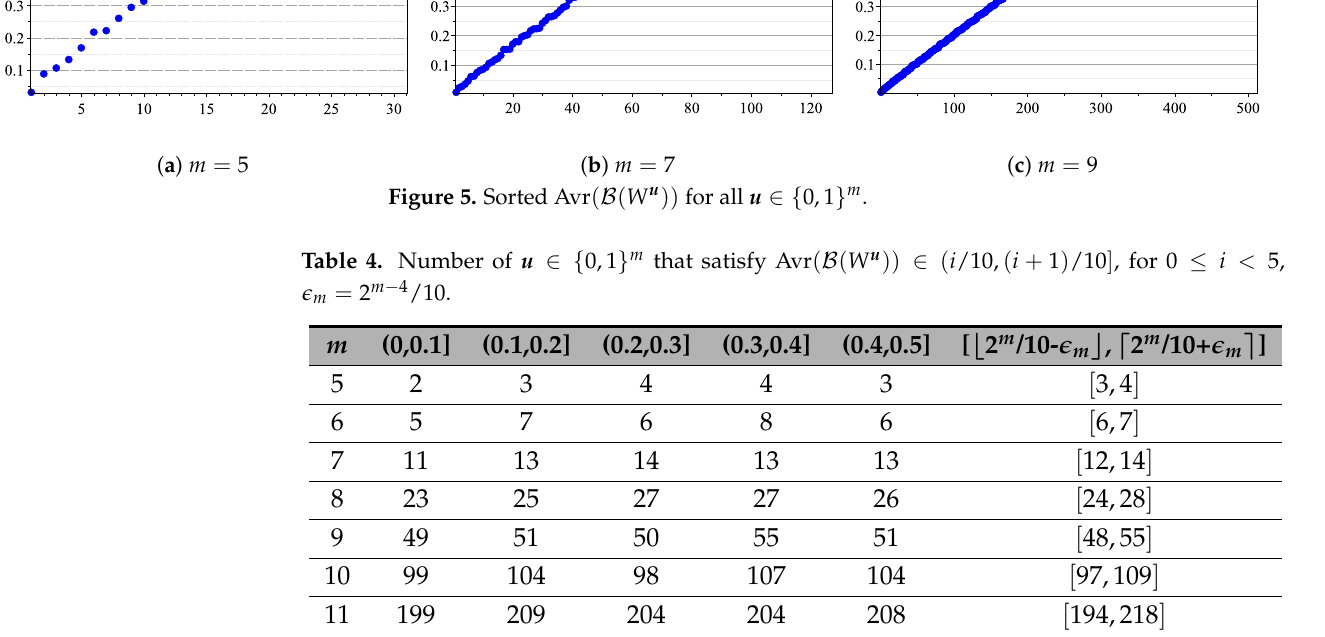
Figure 5. Sorted Avr (